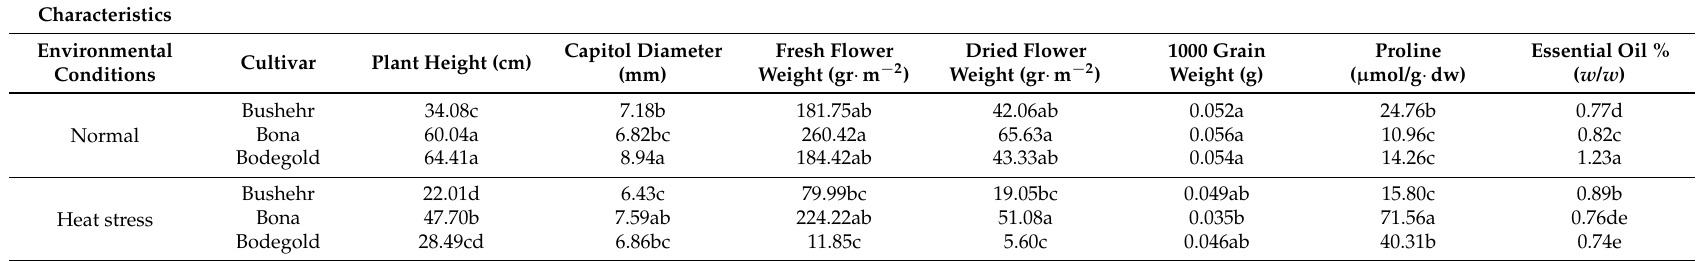
Table 8. Mean comparison of the interaction of environmental conditions ˆ cultivar on studied characteristics of German